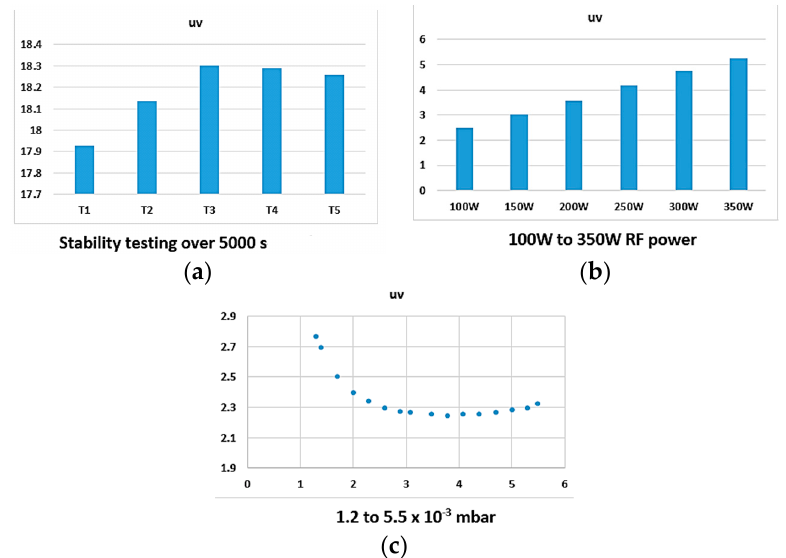
Figure 17. These data demonstrate the ratio (to the total spectral cover from 300 to 800 nm) of the area under the peak in the UV section (300–400 nm) of the spectrum. The UV emissions demonstrate an increasing trend over the 5000 s period, followed by a slight decline and they demonstrate a linearly increasing relationship with the plasma power. The higher chamber pressure seems to be reducing the ratio of the UV emissions to the overall emission within the spectrum. ( a ): Plot tsability test over 5000 s period, ( b ): Effect of plasma power on UV emission ratio, ( c ): Effect of pressure on UV emission ratio.